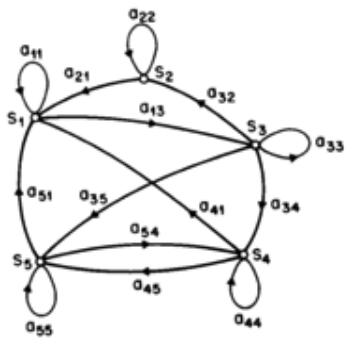
Figure 10. A Markov chain example